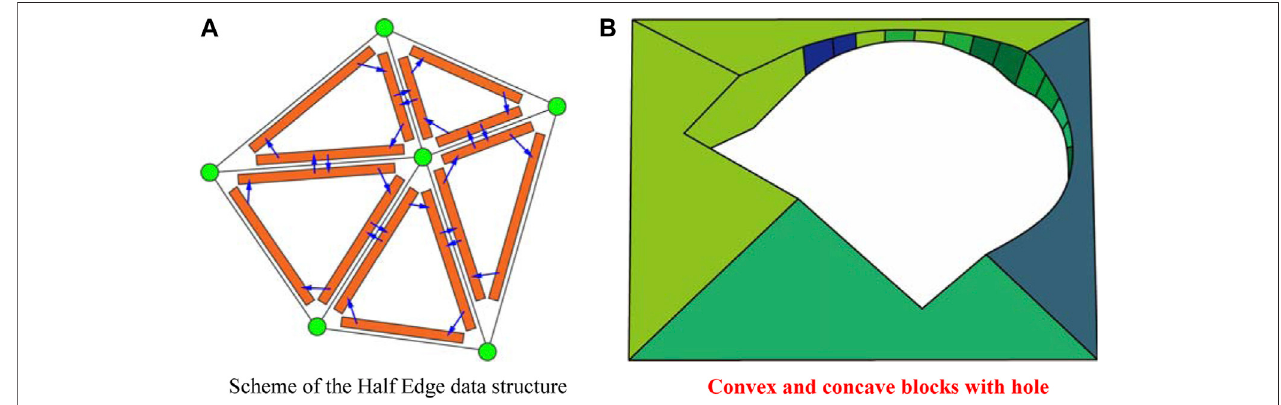
FIGURE 3 | Example of complex rock block representations using the half edge data structure. (A) Scheme of the half edge data structure. (B) Convex and concave blocks with hole.